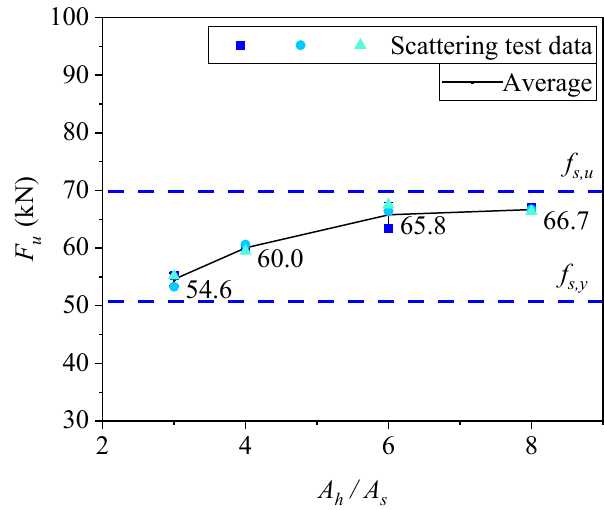
Figure 14. Relationship between head size and bearing capacity.